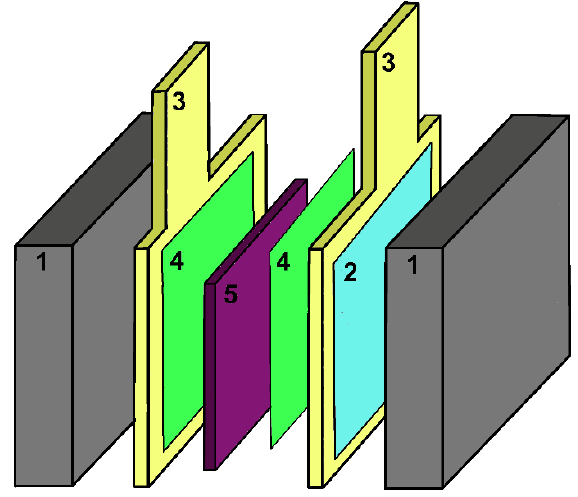
Figure 19. Scheme of the components in PEM fuel cells: bipolar plates (1), current collectors to prevent gas leakage (2), gaskets (3), gas diffusion layer (GDL) (4), membrane electrode assembly (MEA) (5).